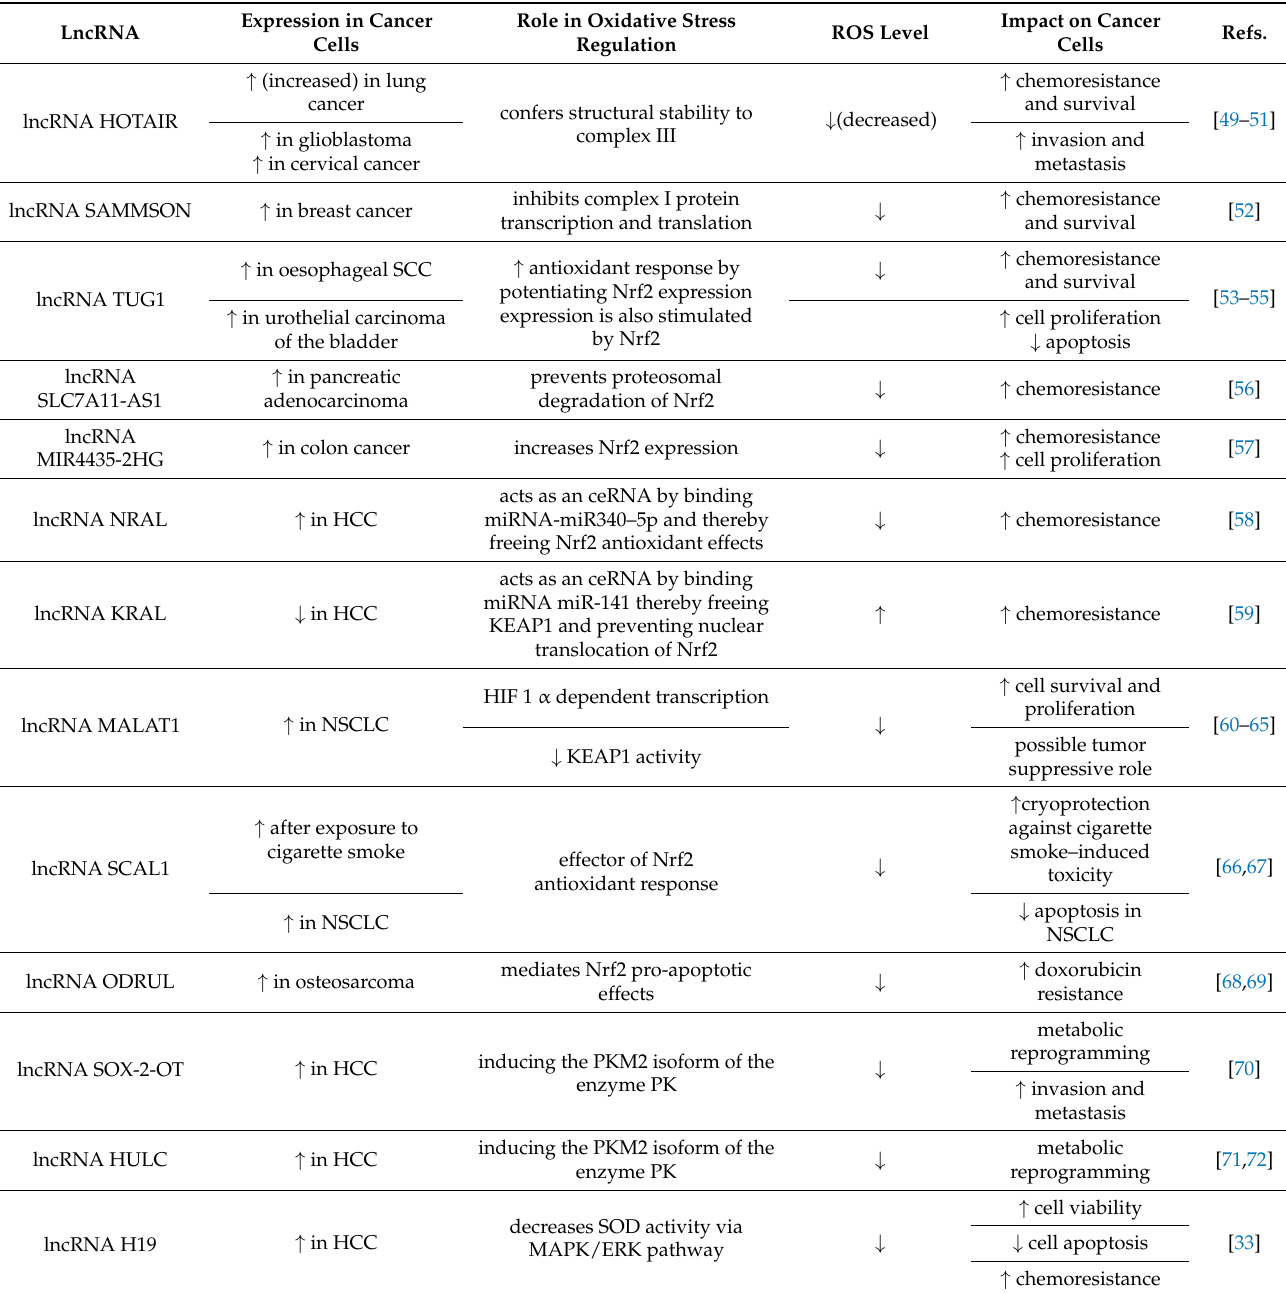
Table 1. Important lncRNAs in the regulation of oxidative stress and their impact on cancer